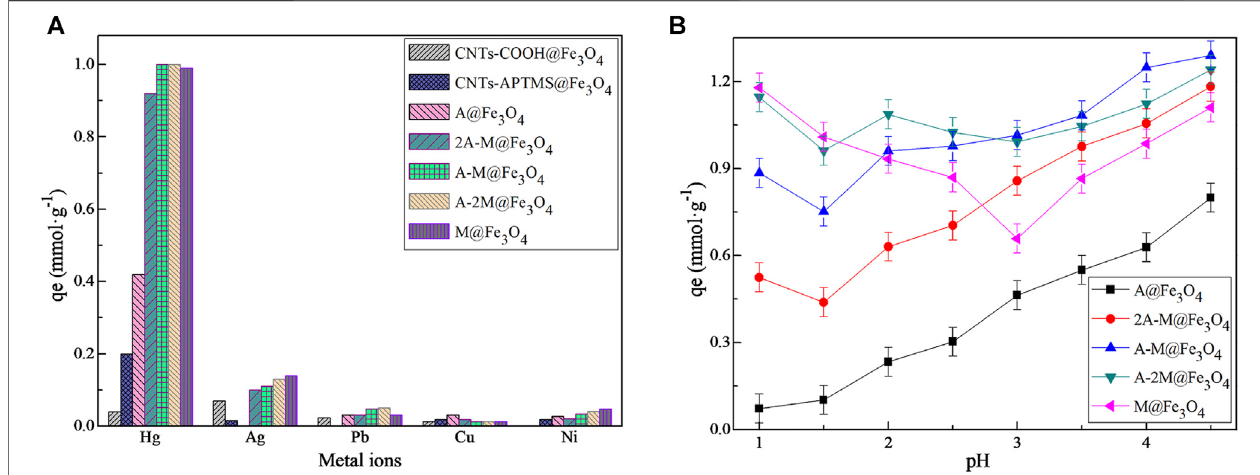
FIGURE 2 | (A) The static adsorption capacities of different materials for different metal ions at pH 2.5 and 25 ° C; (B) the effect of pH on different PSQ/CNTs magnetic composites adsorption for Hg(II).